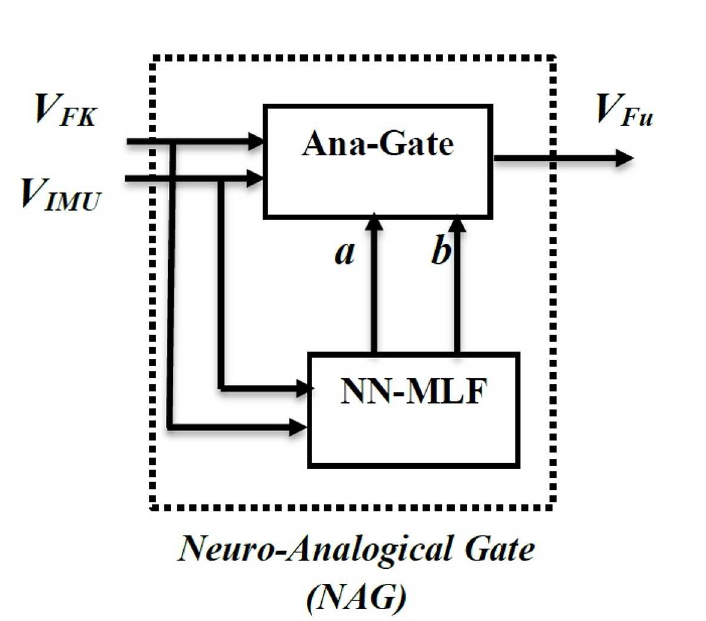
Fig 14. Neuro-analogical gate (NAG).